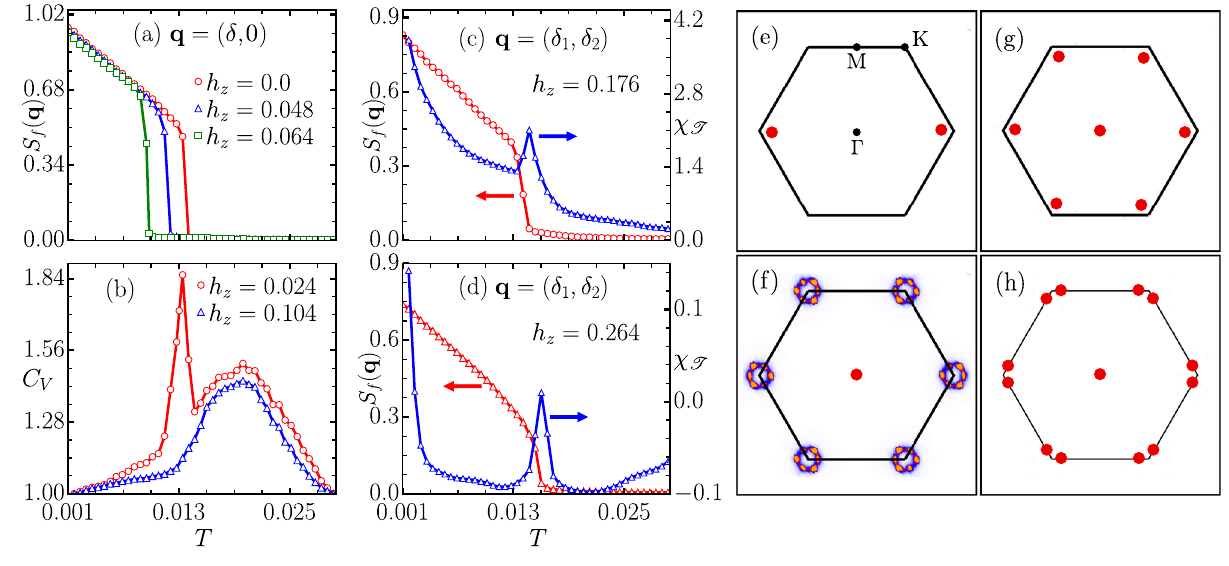
Figure 4. ( a ) SSF peak as a function of temperature for SQ state, ( b ) specific heat variation with temperature to identify CSL state transition, ( c , d ) variation of SSF peak (left axis) and topological susceptibility (right axis) for AF-SkX1 and AF-SkX2 states respectively. ( e – h ) SSF peak locations for four magnetic states displayed in the phase diagram (Fig. 7) SQ, CSL, AF-SkX1 and AF-SkX2 respectively.